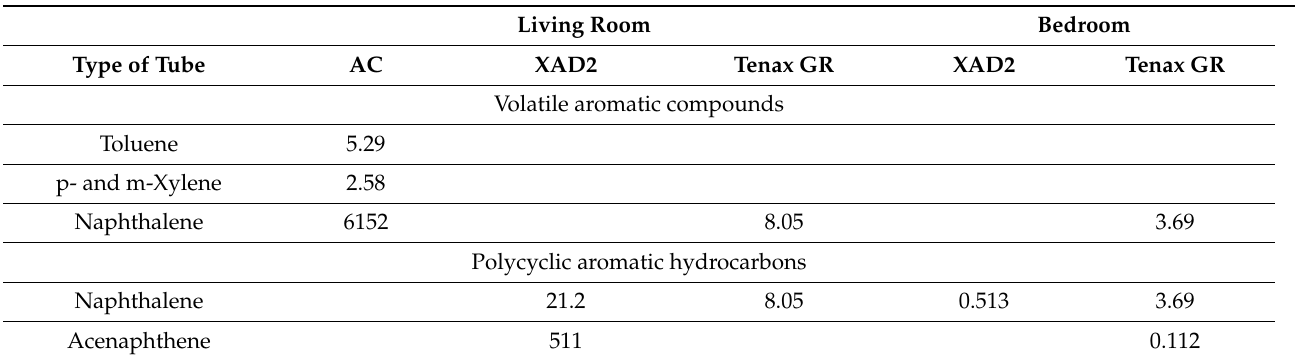
Table 4. VOC and SVOC concentrations ( µ g/m 3 ) in the air extracted from the inter-joist pan form. Living Room